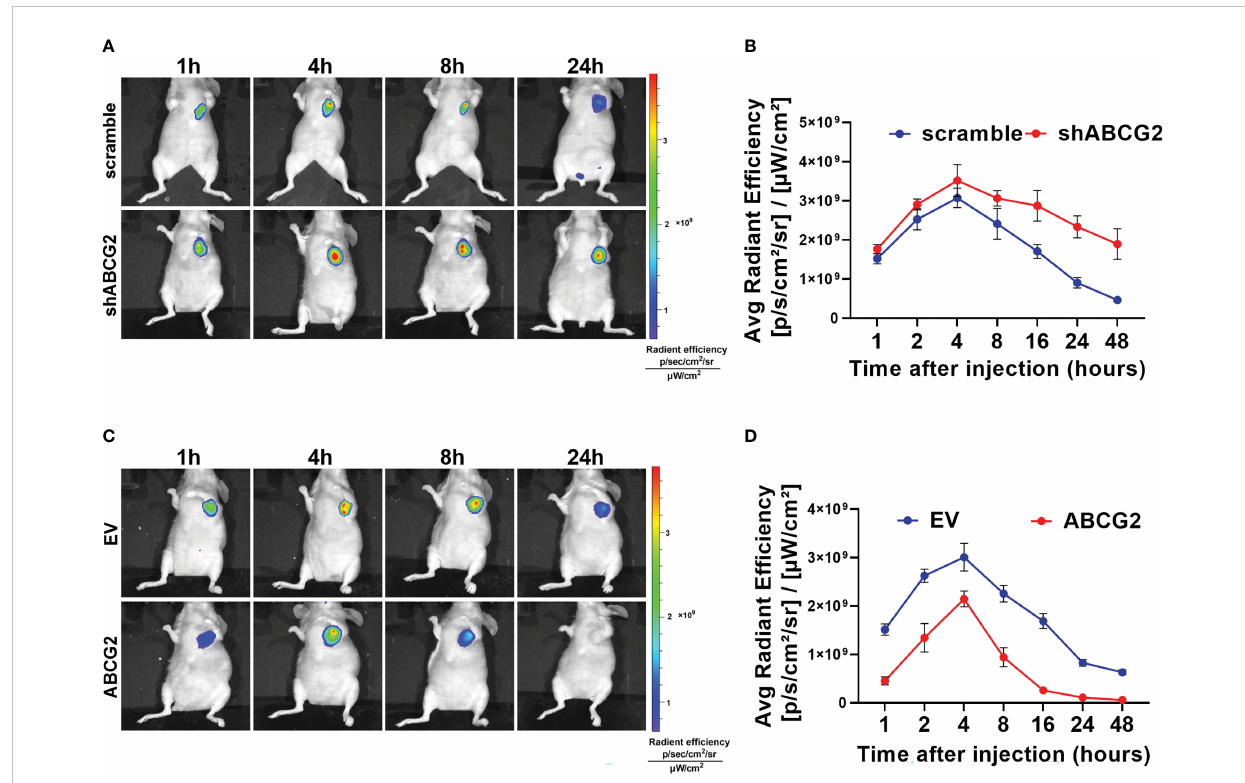
FIGURE 5 The ef fl ux of MHI-148 from HCC cells is mainly mediated by ABCG2 in vivo . (A) Time-dependent intensity images of nude mice bearing subcutaneous tumor xenografts of SNU-739 cells with ABCG2-knockdown (shABCG2) after receiving an intravenous injection of MHI-148 (0.75 m mol kg -1 ). (B) Quanti fi cation of MHI-148 fl uorescence intensity in (A) . (C) Time-dependent intensity images of nude mice bearing subcutaneous tumor xenografts of SNU-739 cells with overexpressed ABCG2 (ABCG2) after receiving an intravenous injection of MHI-148 (0.75 m mol kg -1 ). (D) Quanti fi cation of MHI-148 fl uorescence intensity in (C) . Data shown are the mean ± SD from three independent experiments, where